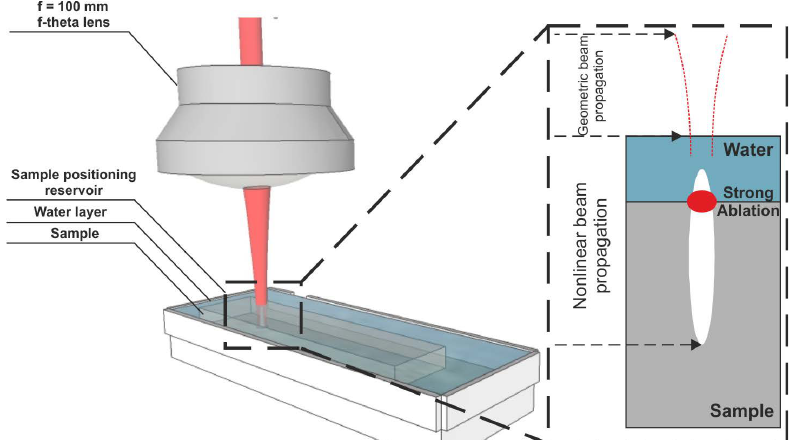
Figure 1. Micromachining setup. The laser beam directed by a scanner is focused using an f-theta lens onto a sample that is covered with a thin layer of water. Within the water layer, the pulses undergo transformation to multiple filaments, which are used for micromachining. Average